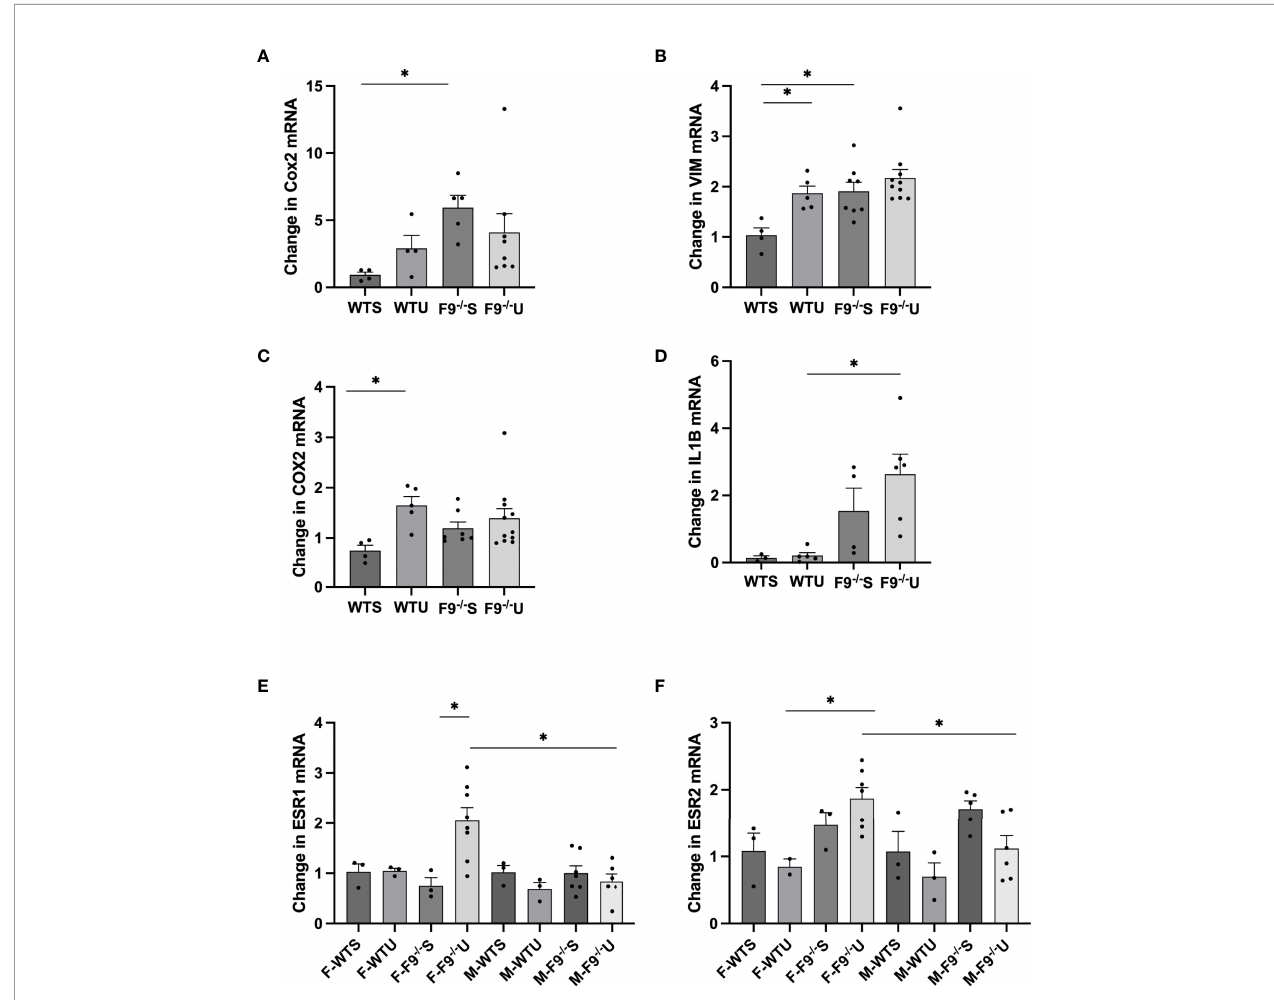
FIGURE 3 | FZD9 loss in vivo alters mRNA expression of downstream targets. RNA from mouse lung was harvested from wild type saline (WTS), wild type urethane (WTU), FZD9 -/- saline (F9 -/- S), and FZD9 -/- urethane (F9 -/- U) groups and gene expression measured by qPCR. (A) FN1, (B) VIM, (C) COX2, (D) IL1B, (E) ESR1, (F) ESR2. PCR was normalized to RPS18 and measured in triplicate. F-, Female; M-, Male. Signi fi cance was measured by one-way ANOVA and